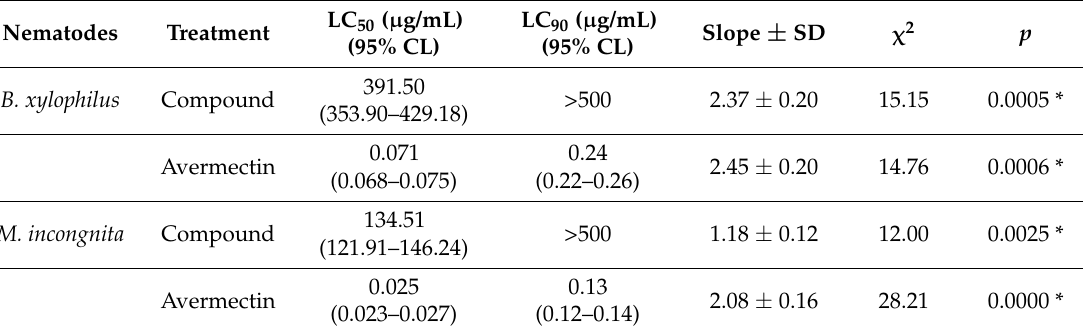
Nematicidal activity of the isolated pyrrolidine alkaloid against juveniles of Bursaphelenchus xylophilus and Meloidogynein congnita